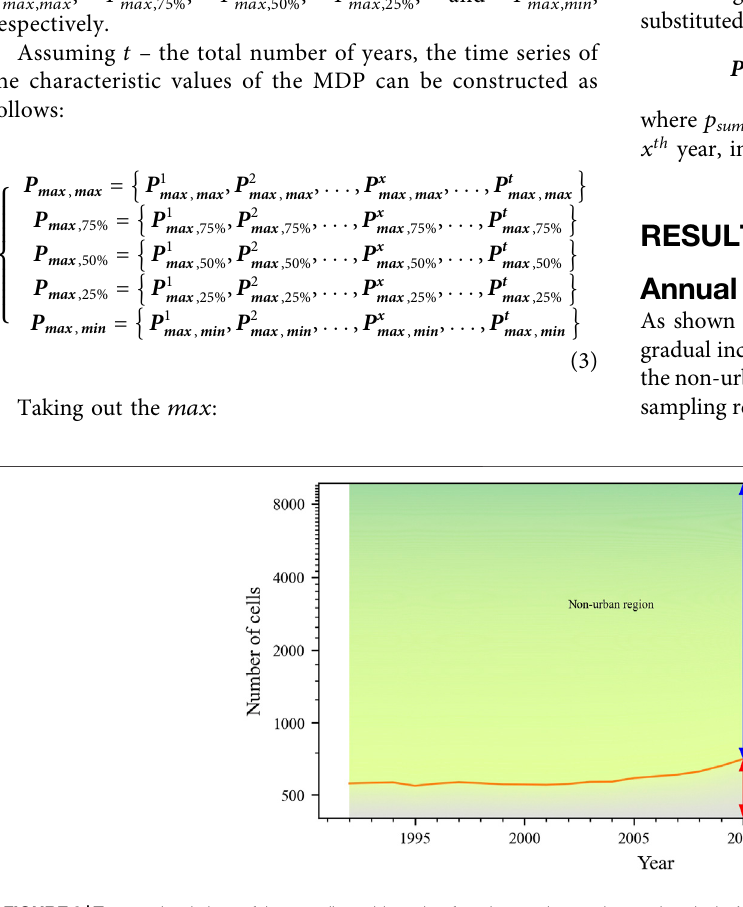
Frontiers in Earth Science |